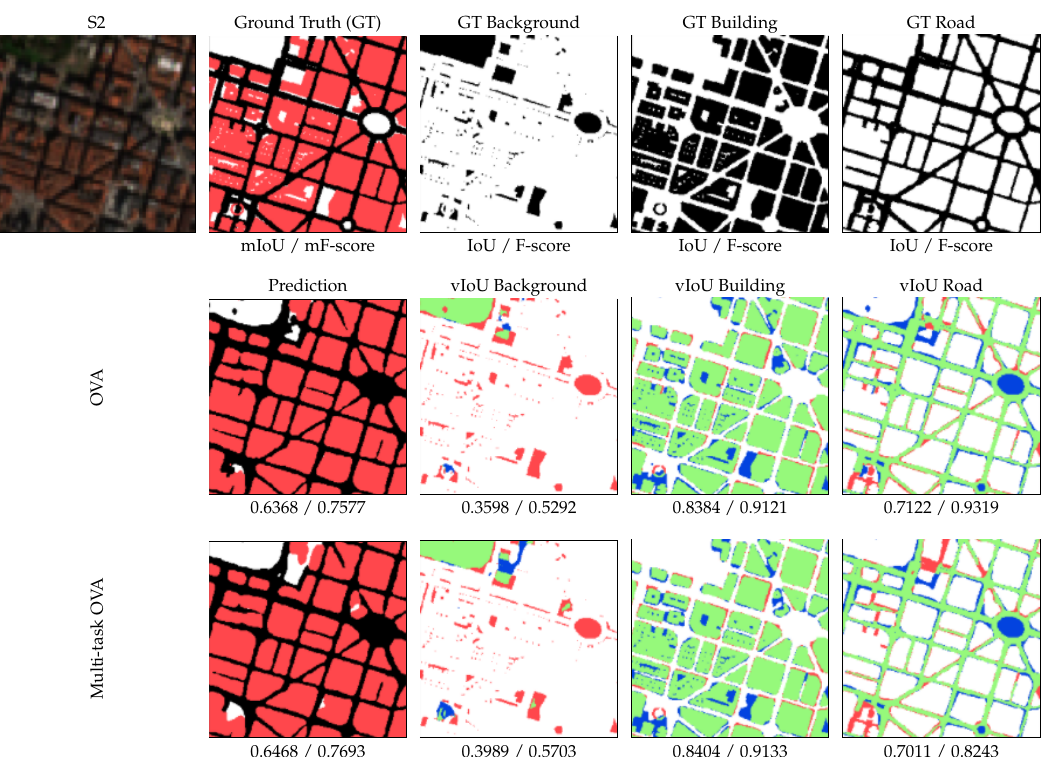
Figure 10. Qualitative results for the benefits of using a multi-task learning scheme. Visual comparison of the results obtained with the OVA binary decomposition strategy and its multi-task variant, for a zone taken from Barcelona North city in the test set. TP are presented in green, FP in blue, FN in red and TN in